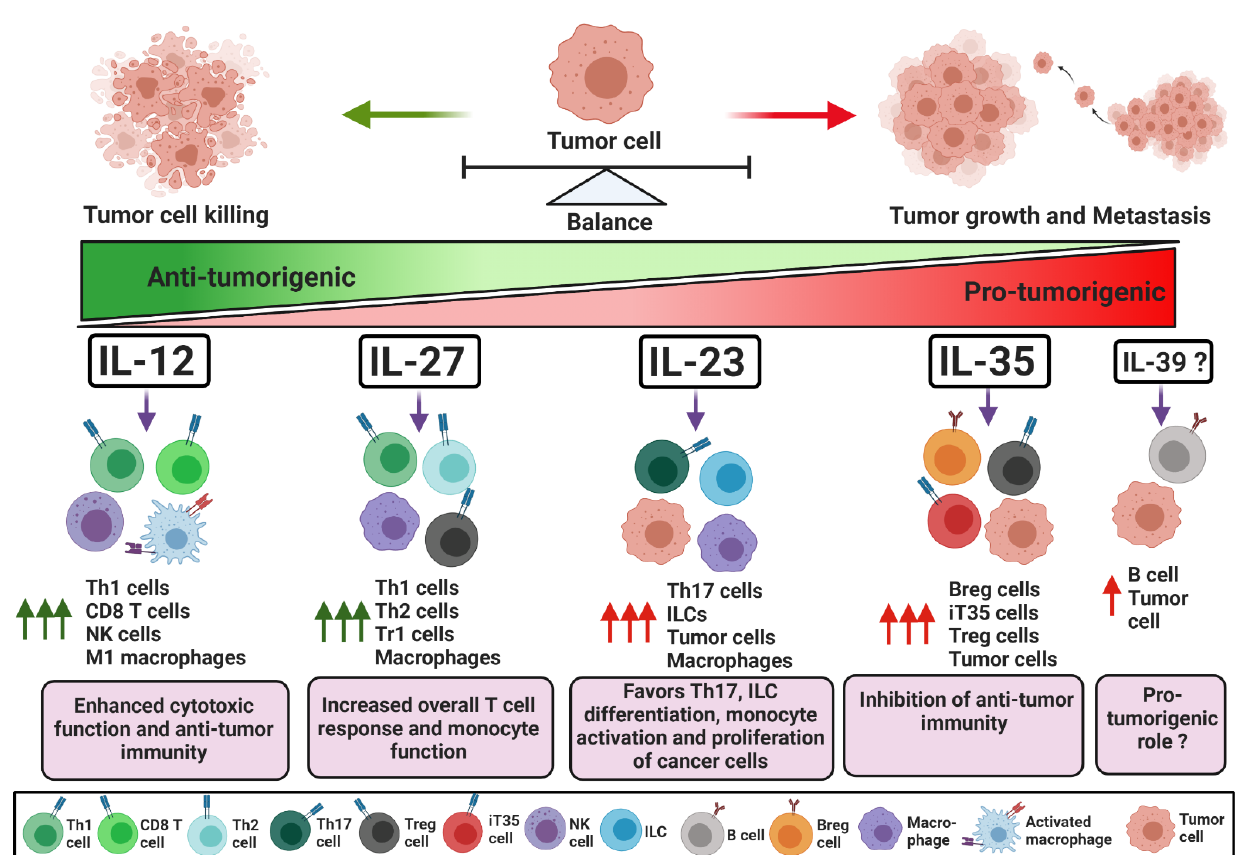
Figure 1. Role of IL-12 family cytokines in maintaining a balance between effector and regulatory immune responses in tumorigenesis. IL-12 activates an effector immune response against tumor cells by promoting both M1 macrophage polarization and IFN-γ- production by Th1 cells, which in turn, stimulate anti-tumor cytotoxic CD8 + and NK cells. IL-27 and IL-23 have dual effects on immune cells in cancer. IL-27 and IL-23 can induce an overall T cell-mediated immune response and also modulate immune suppressive macrophages. Furthermore, IL-23 can stimulate the proliferation and growth of tumor cells. Conversely, IL-35 is a strong immune suppressive cytokine; it induces regulatory B and T cell activation and proliferation that subverts anti-tumor immunity and stimulates tumor growth and metastasis. IL-39 was recently shown to be secreted by B cells and may increase cancer cell proliferation. ↑ Arrow indicates increase in respective cell type activity; Tr1—T regulatory type 1; ILC—innate lymphoid cell; Breg—regulatory B cell; Treg—regulatory T cell; iT35—IL35-inducible regulatory T cell.